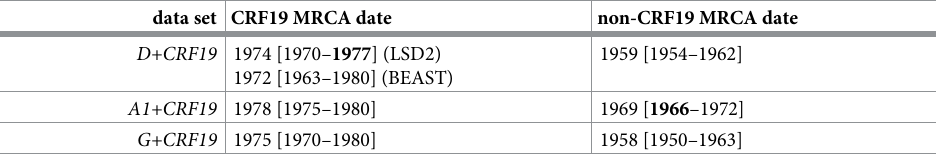
Table 3. Dates and CIs/HPD of the MRCA of CRF19 and its non-CRF19 parent, etimated on different data